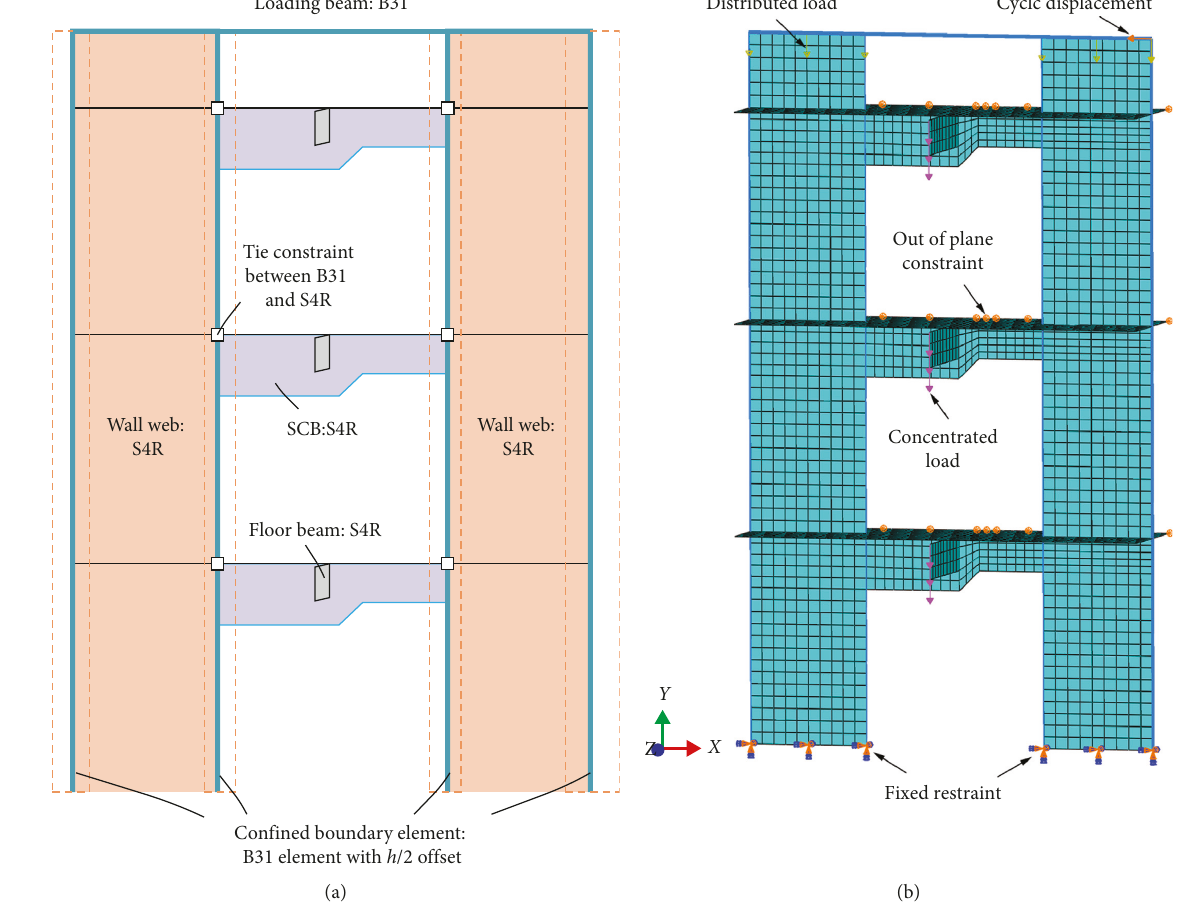
Figure 17: Overall FE model of the coupled wall with the SCBs. (a) Element selection. (b) ABAQUS model.